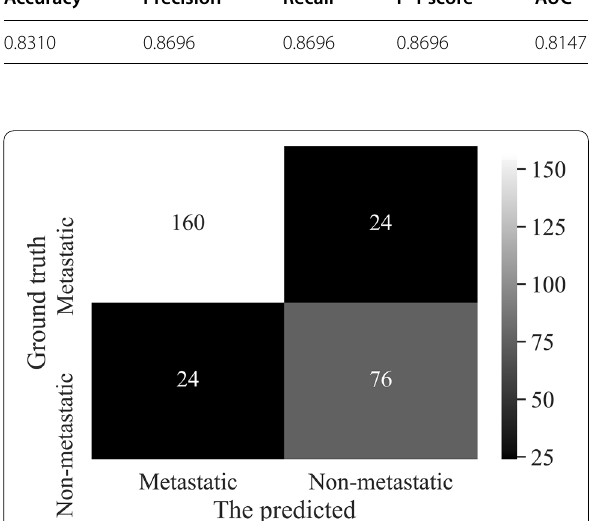
Fig. 10 Confusion matrix of two-class classification obtained by